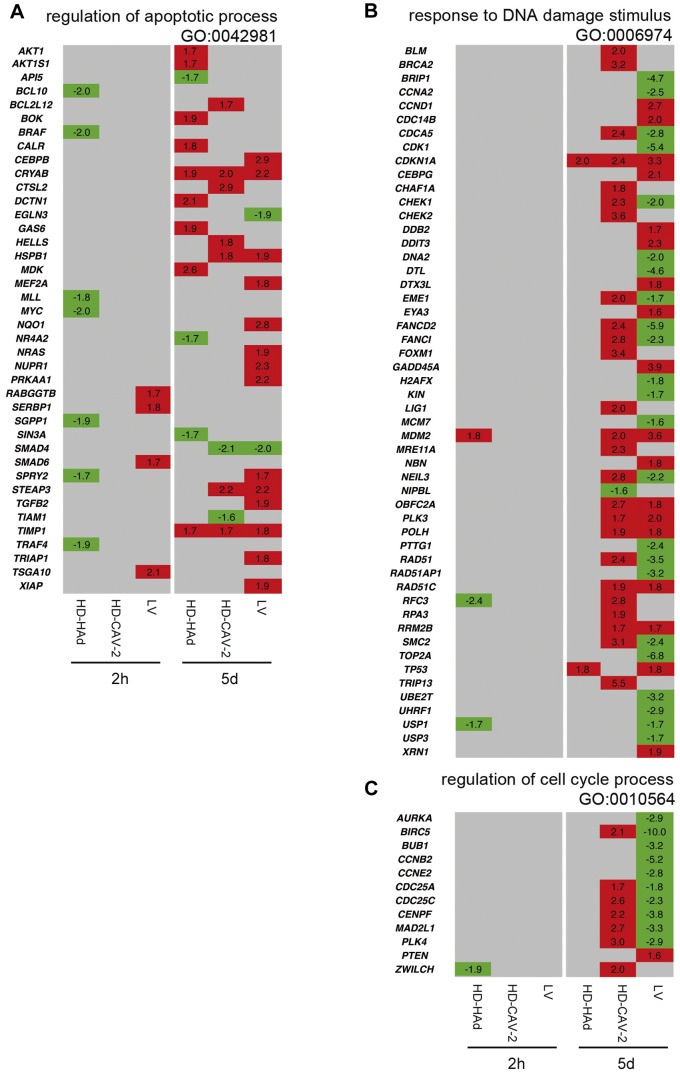
Comparative analysis of cell cycle and DNA damage gene expression profiles induced by HD-HAd, HD-CAV-2 and LV.(a–c) Heat maps of genes identified by combined IPA and GO analysis with a threshold set at p≤0.01. The relative gene modulation fold change values are indicated; in red, upregulated genes, in green, downregulated, and in grey, genes with unmodified expression with respect to mock. The most prominent trait of this analysis is the divergent modulation of the subgroup GO: 00006974 (“Regulation of DNA damage stimulus”) and GO: 0010564 (“Regulation of cell cycle process”) by HD-CAV-2 and LV at 5 days posttransduction.